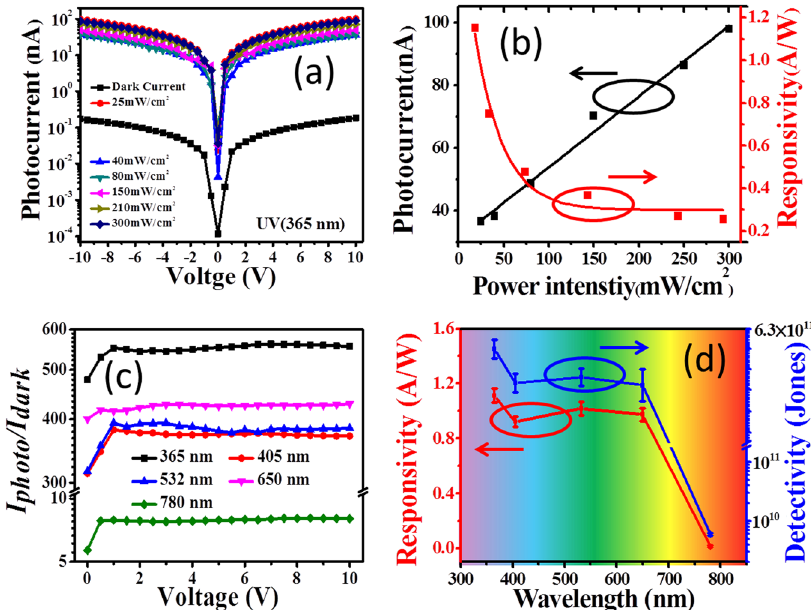
Fig. 3 a I – V curves of PBDTT- ff Qx/PCBM BHJ photodetector in dark and under 365 nm light illumination at the different light density. b Photocurrent and R as a function of the light intensity at 10 V. c I photo / I dark as a function of the bias voltage at the different wavelength. d R and D* versus the wavelength for the PBDTT- ff Qx/PCBM BHJ photodetector. The data are the average value of fi ve photodetector devices